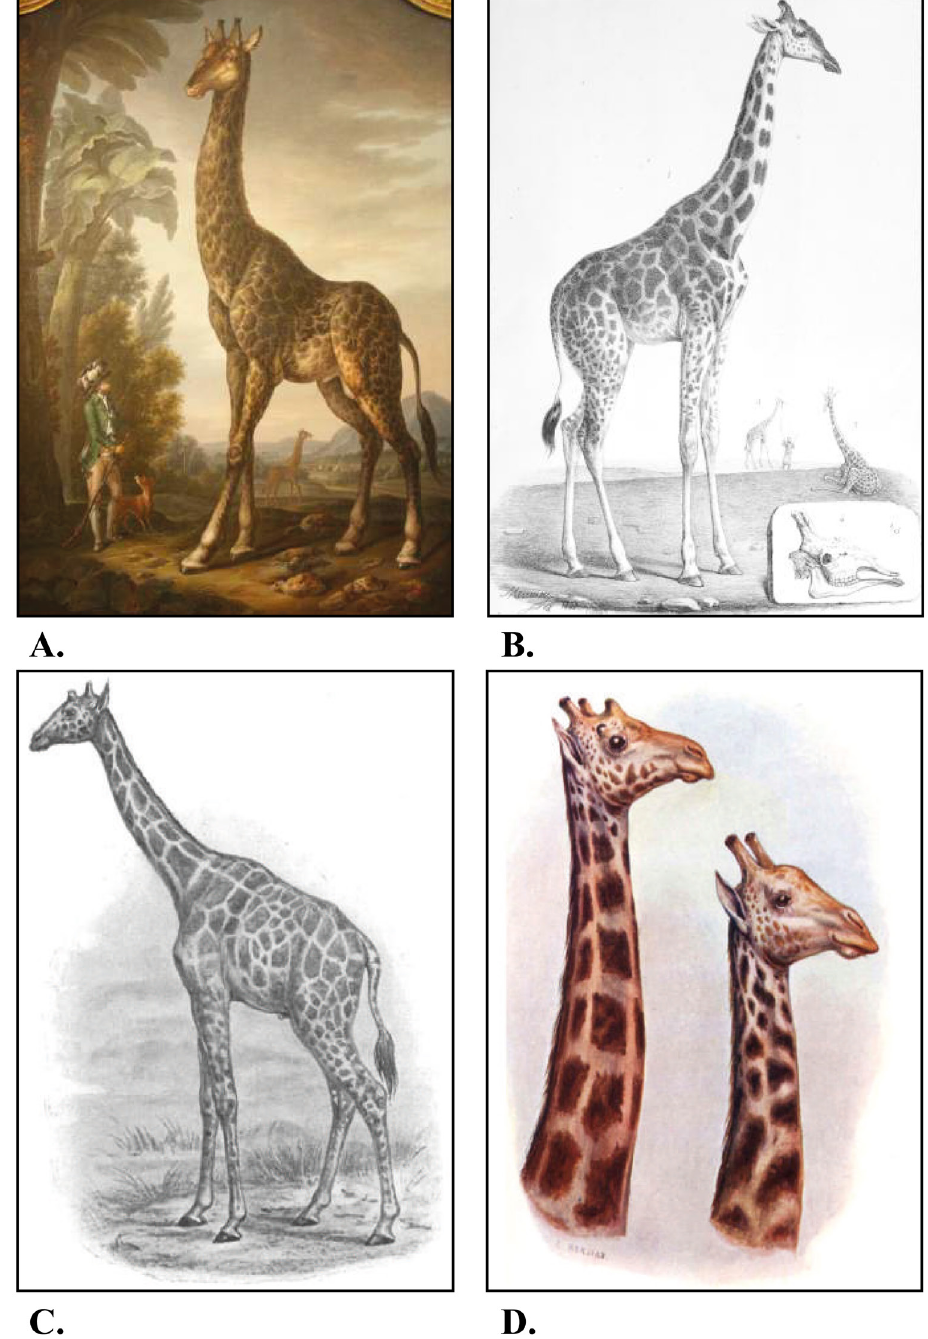
Fig. 2. Illustrations of historical giraffe specimens. A . The ʻGiraffe of Levaillantʼ, anonymous painting made in the late 18 th century and early 19 th century, exhibited in ʻhôtel de Magnyʼ, Jardin des Plantes in Paris (France). B . The ʻGiraffe from Sennaarʼ, representing a lithography of Zarafa (MNHN-1845-211) and the skull of a giraffe from the Cape region (Geoffroy Saint-Hilaire 1827). C . Drawing of the holotype of Giraffa camelopardalis congoensis Lydekker, 1903 (RMCA-452), housed in the Royal Museum of Central Africa, Tervuren (Belgium) (Lydekker 1904). D . Head drawings of the holotypes of G. c. cottoni Lydekker, 1904 (NHMUK-1904.1.21.1, left) and G. g. wardi Lydekker, 1904 (NHMUK-1903.11.18.1, right) (Lydekker